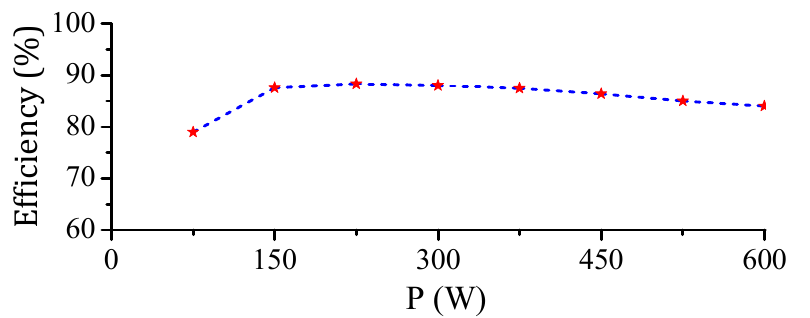
Figure 18. Efficiency profile of a single flyback module of the proposed MFBDI.